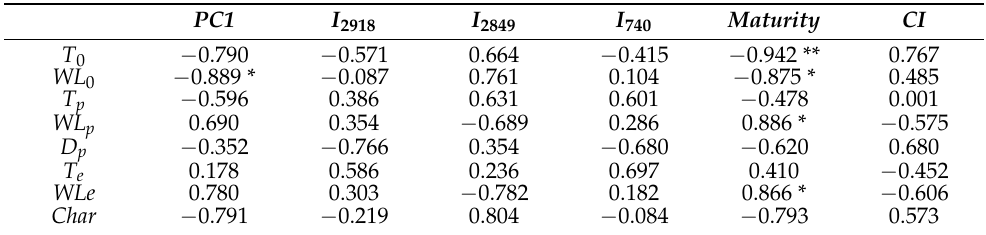
Table 3. Correlation coefficients between the ATR FT-IR-based parameters and thermal properties of the six fiber